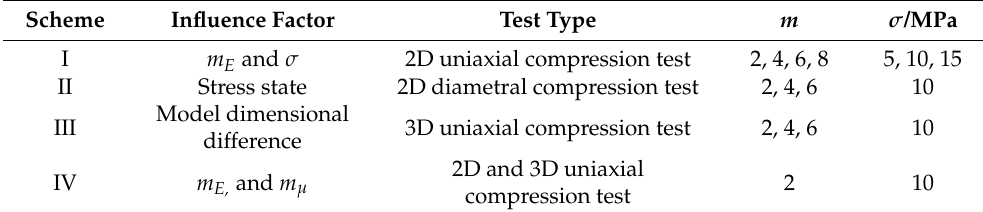
Table 1. Verification schemes of the DF-PF inversion